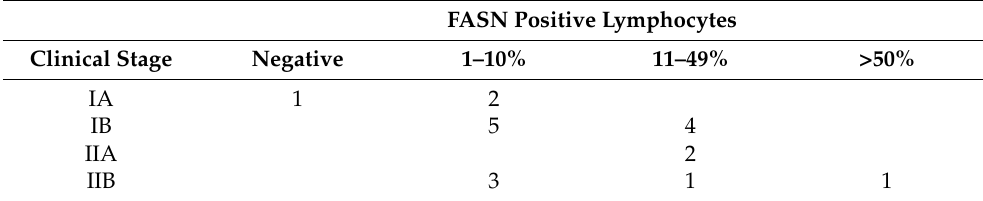
Table 1. Numbers of MF patients according to their clinical stage and frequency of FASN positive lymphocytes in the